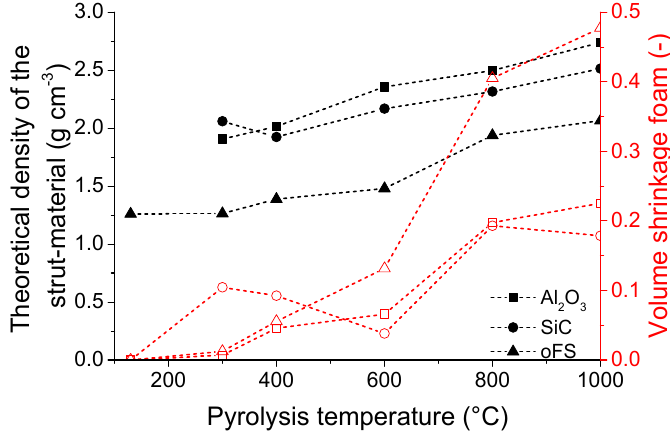
Figure 3. Dependence of the theoretical density of the strut material measured on crushed filler-loaded (Al 2 O 3 , SiC) and filler-free foams (oFS) and volumetric shrinkage of the temperature treated foams in dependence of the pyrolysis temperature.